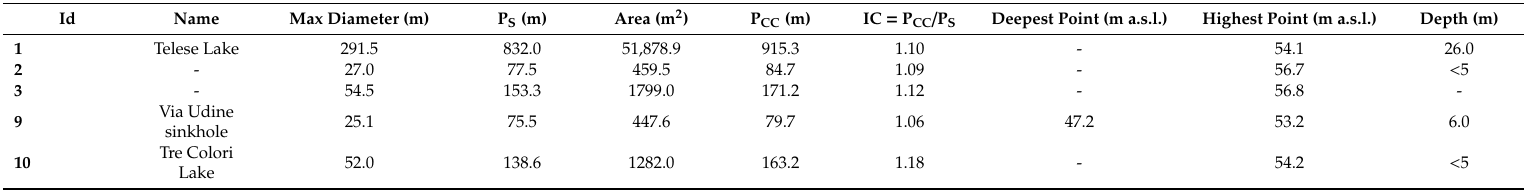
Table 1. Main features of sinkholes of the Telese Plain. P S , sinkhole perimeter; P CC , maximum circumscribed circumference of the sinkhole perimeter; IC, circularity index. Features of sinkholes from 4 to 8 and 11 were masked by buildings, so only their location is known.